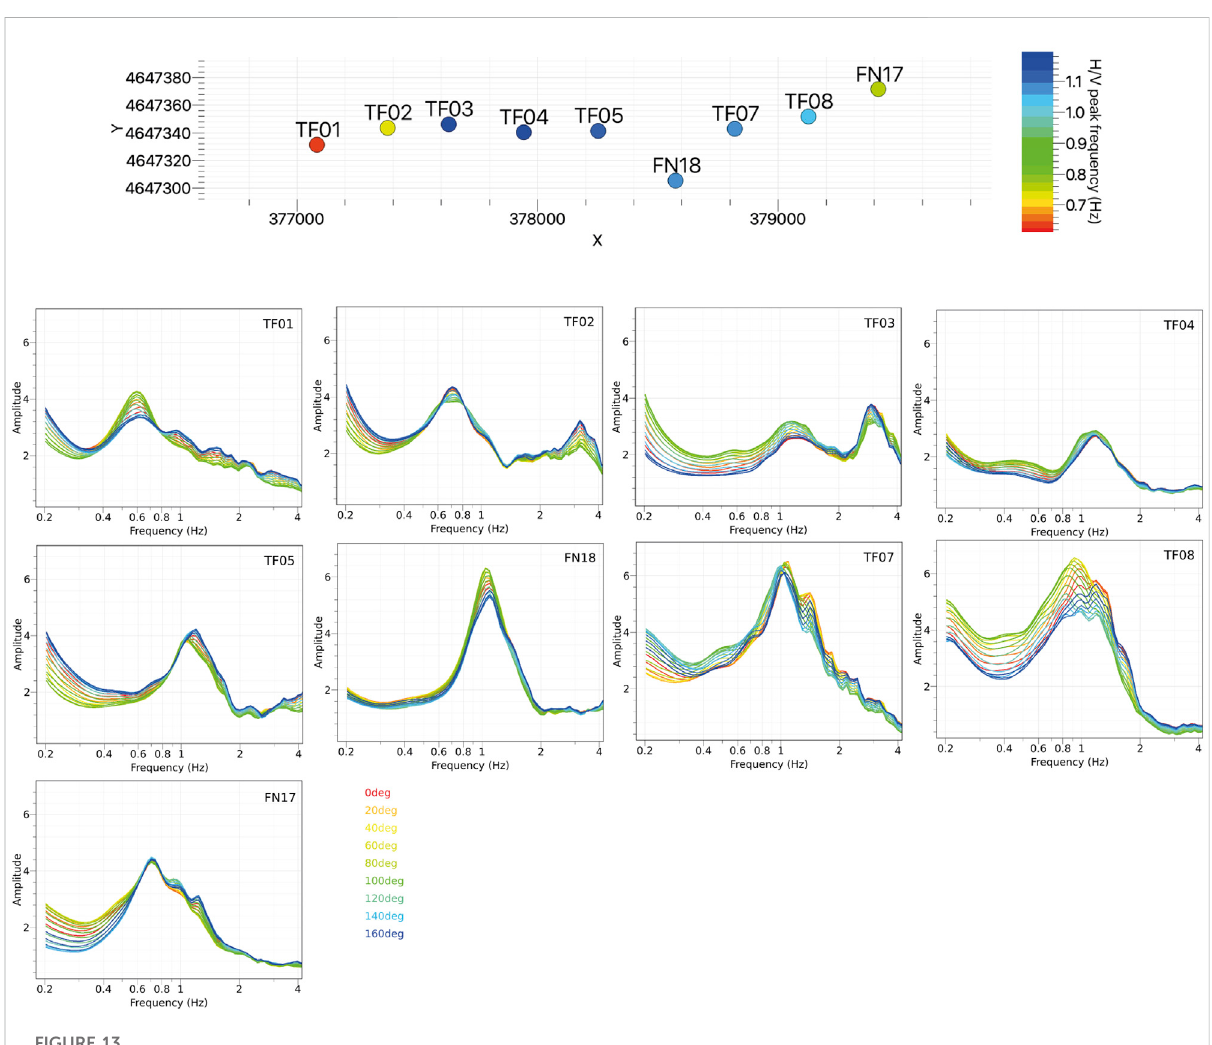
FIGURE 13 Directional HVNSR of Section